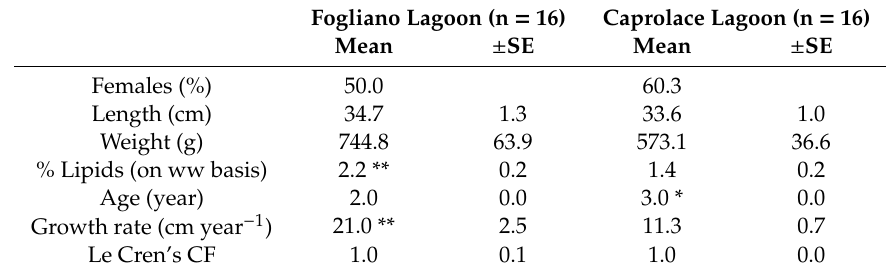
Table 2. Mean ± SE of total length, weight, lipid content, age, annual growth rate, and of Le Cren’s relative condition factor of thick-lipped mullet samples from Fogliano and Caprolace.